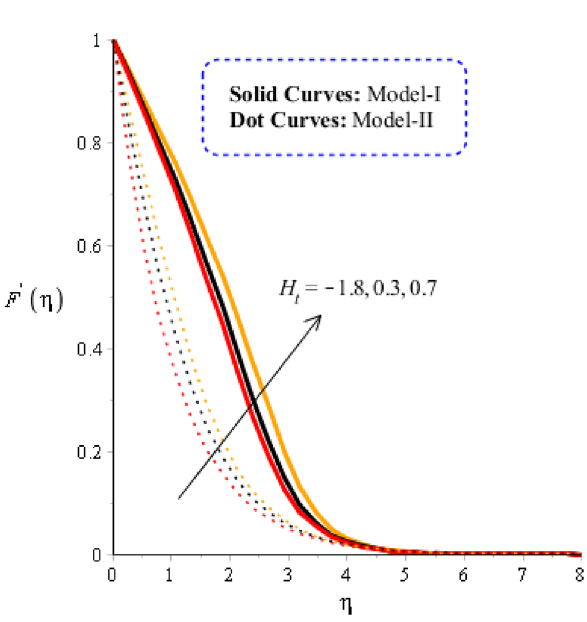
Figure 6. Graphical impact of H t on velocity distribution when α = 0.5, m = 0.3, Re = 4.0, we = 3.0, M = 3.0, Pr = 206,